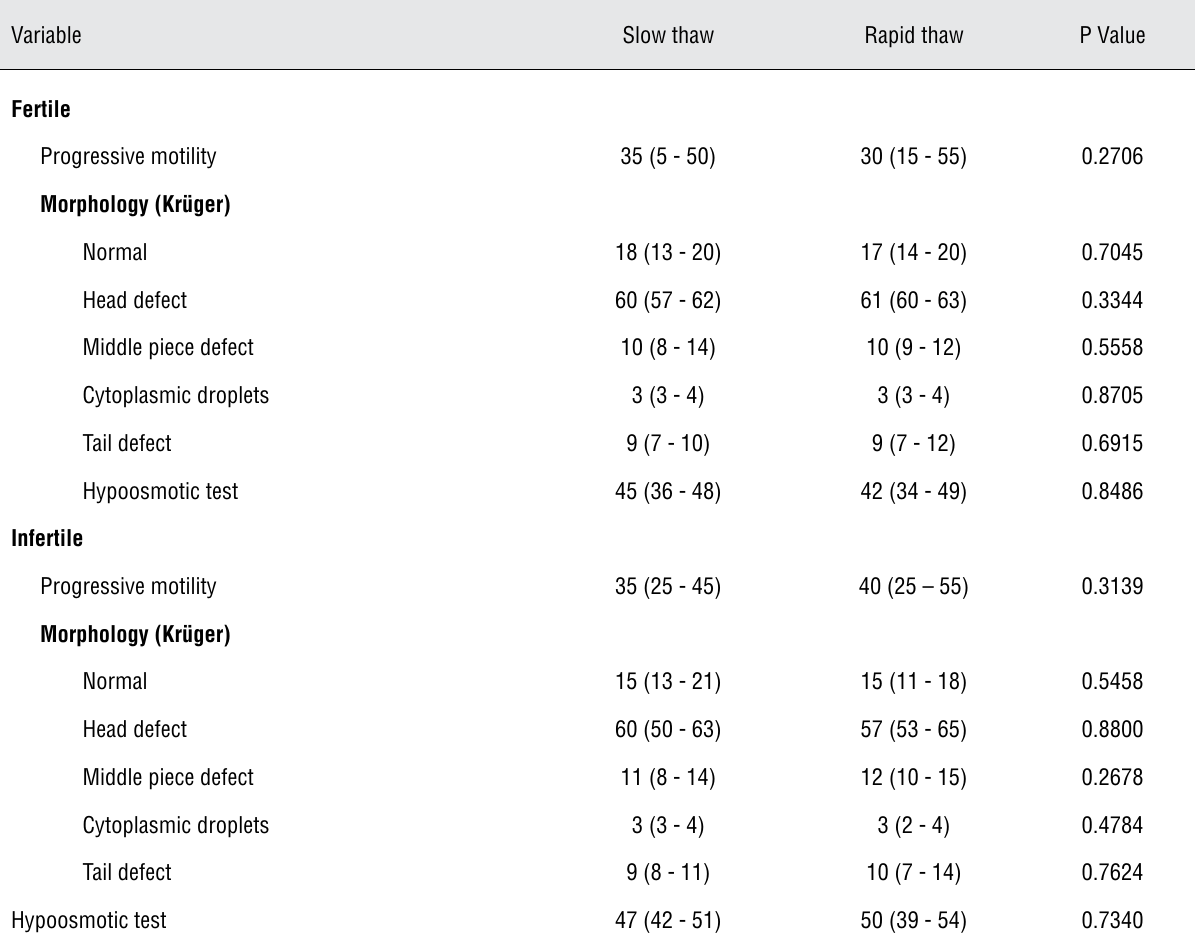
Table 2 - sperm evaluation according to thawing